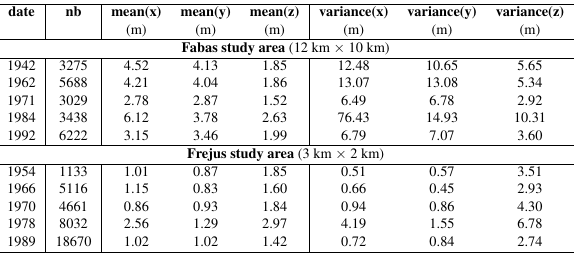
Table 2. Number of automatic GCPs extracted ( nb ) and comparison of their 3D ground coordinates (after fine absolute georeferencing vs. current